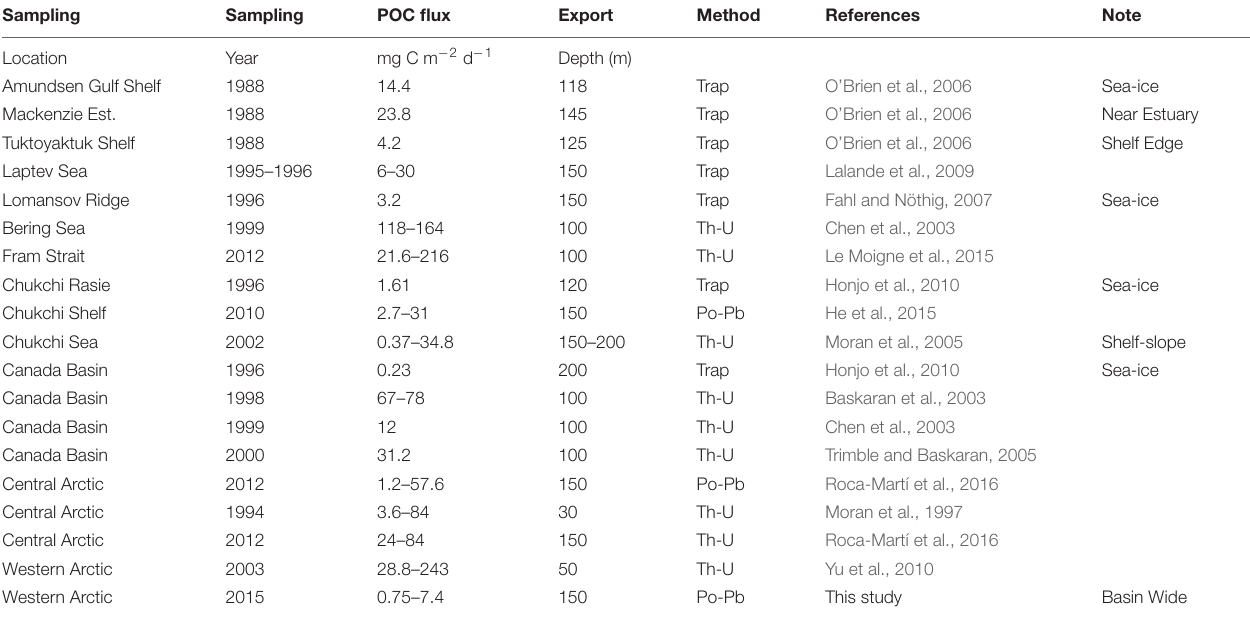
TABLE 1 | Published data on POC fluxes in the Arctic